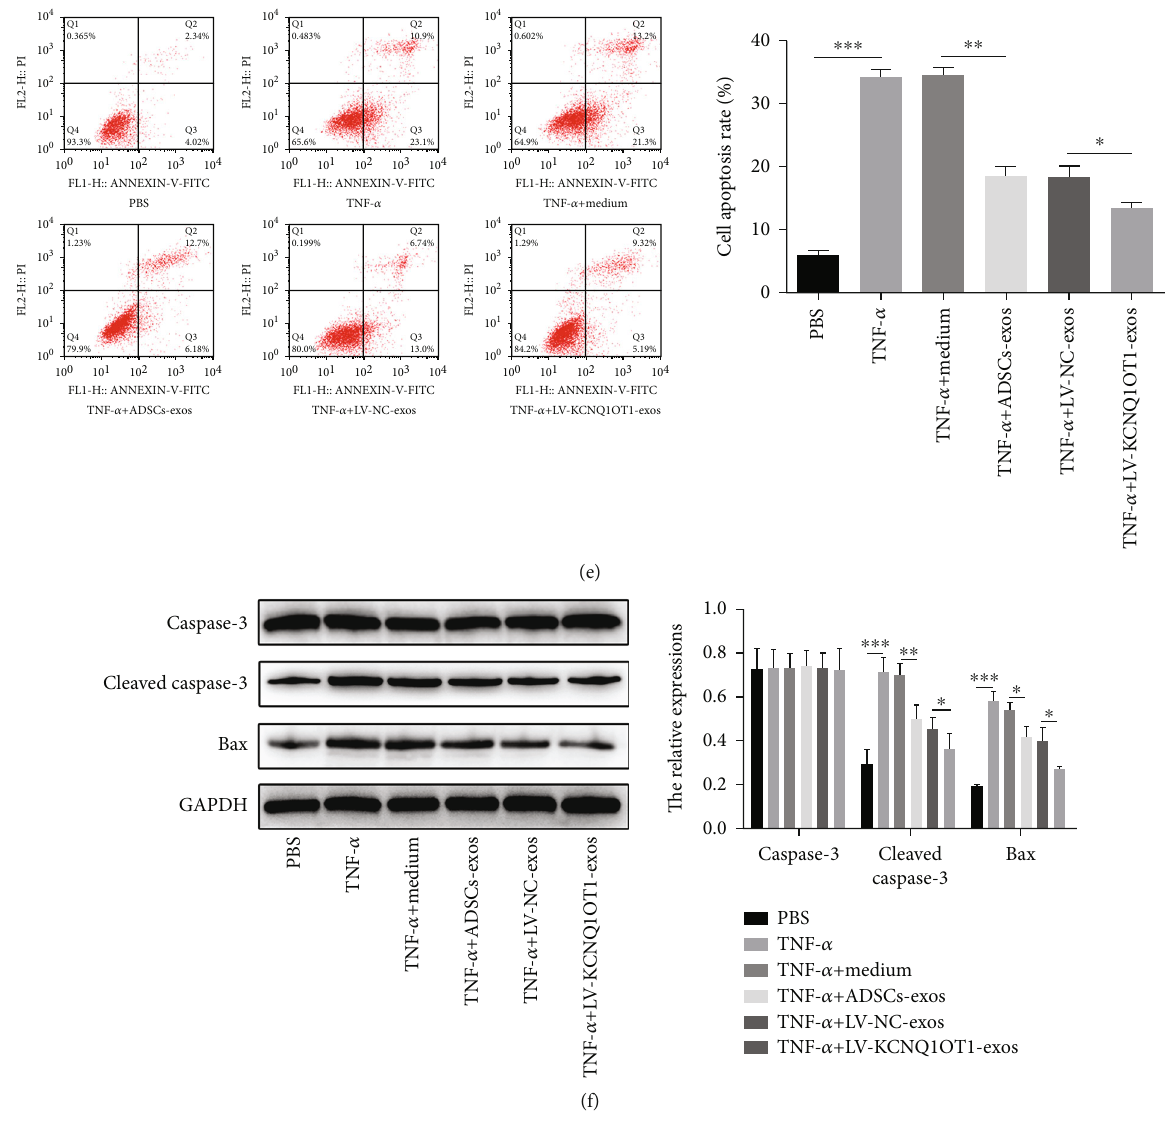
Figure 5: KCNQ1OT1-Exos inhibit TNF- α -induced cytotoxicity and apoptosis of primary osteoblasts. (a, b) The expression of KCNQ1OT1 in ADSCs or exosomes derived from the ADSCs after di ff erent transfections was elevated, but the expression of miR-141-5p was downregulated compared with that in LV-NC-treated group after the transfection of LV-KCNQ1OT1. (c) KCNQ1OT1 expression was upregulated in primary osteoblasts treated with LV-KCNQ1OT1-Exos compared to NC-Exos. (d) In primary osteoblasts, LV- KCNQ1OT1-Exos mitigated the negative e ff ect of TNF- α on cell viability, while ADSCs-Exos exerted a weaker stimulative e ff ect on cell viability compared to LV-KCNQ1OT1-Exos. (e) When primary osteoblasts were cocultured with LV-KCNQ1OT1-Exos, the TNF- α - induced cell apoptosis was reversed and ADSCs-Exos exerted a weaker inhibitory e ff ect on cell apoptosis compared to LV-KCNQ1OT1- Exos. (f) The expression of Bax and cleaved caspase-3 in primary osteoblasts was blocked after coculture of LV-KCNQ1OT1-Exos. ∗ P < 0 : 05 , ∗∗ P < 0 : 01 , and ∗∗∗ P < 0 : 001